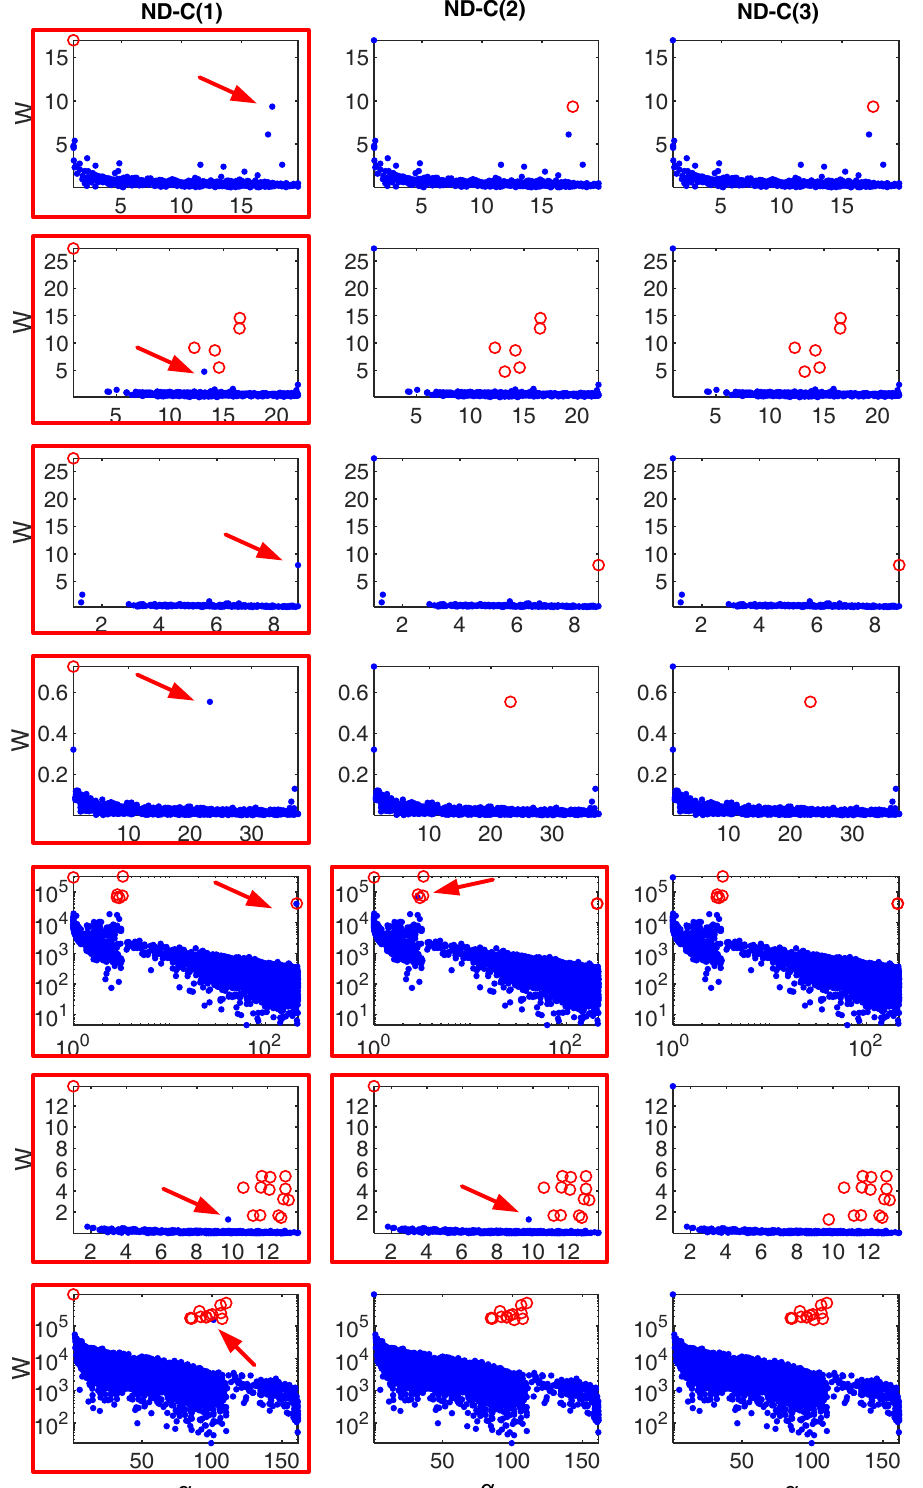
Figure 9. The 2-classification Decision Diagrams of ND-C(1), ND-C(2), and ND-C(3) on all the outlier- contaminated test datasets shown in Figure 8. Each row shows the 2-classification Decision Diagrams of the test dataset shown in the same row of Figure 8. The blue points correspond to the edges that are not automatically removed by the cutting methods; the red points correspond to the edges that are automatic removed by the cutting methods. The red rectangles marker the 2-classification Decision Diagrams with falsely classified points, which are in blue and pointed by the red